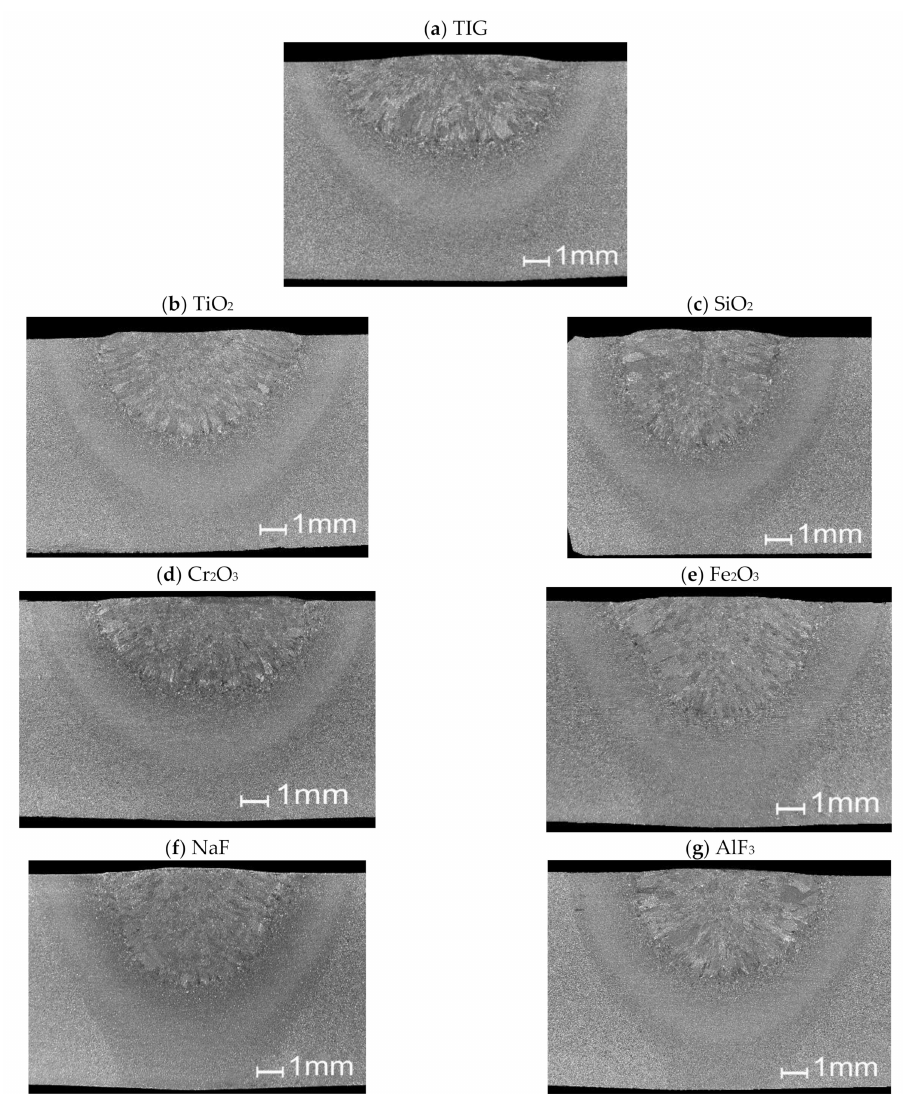
Figure 3. Macrostructure of the welds made on structural fine-grained steel S355J2+N using ( a ) conventional TIG without flux and A-TIG with various fluxes: ( b ) TiO 2 ( c ) SiO 2 ( d ) Cr 2 O 3 ( e ) Fe 2 O 3 ( f ) NaF ( g ) AlF 3